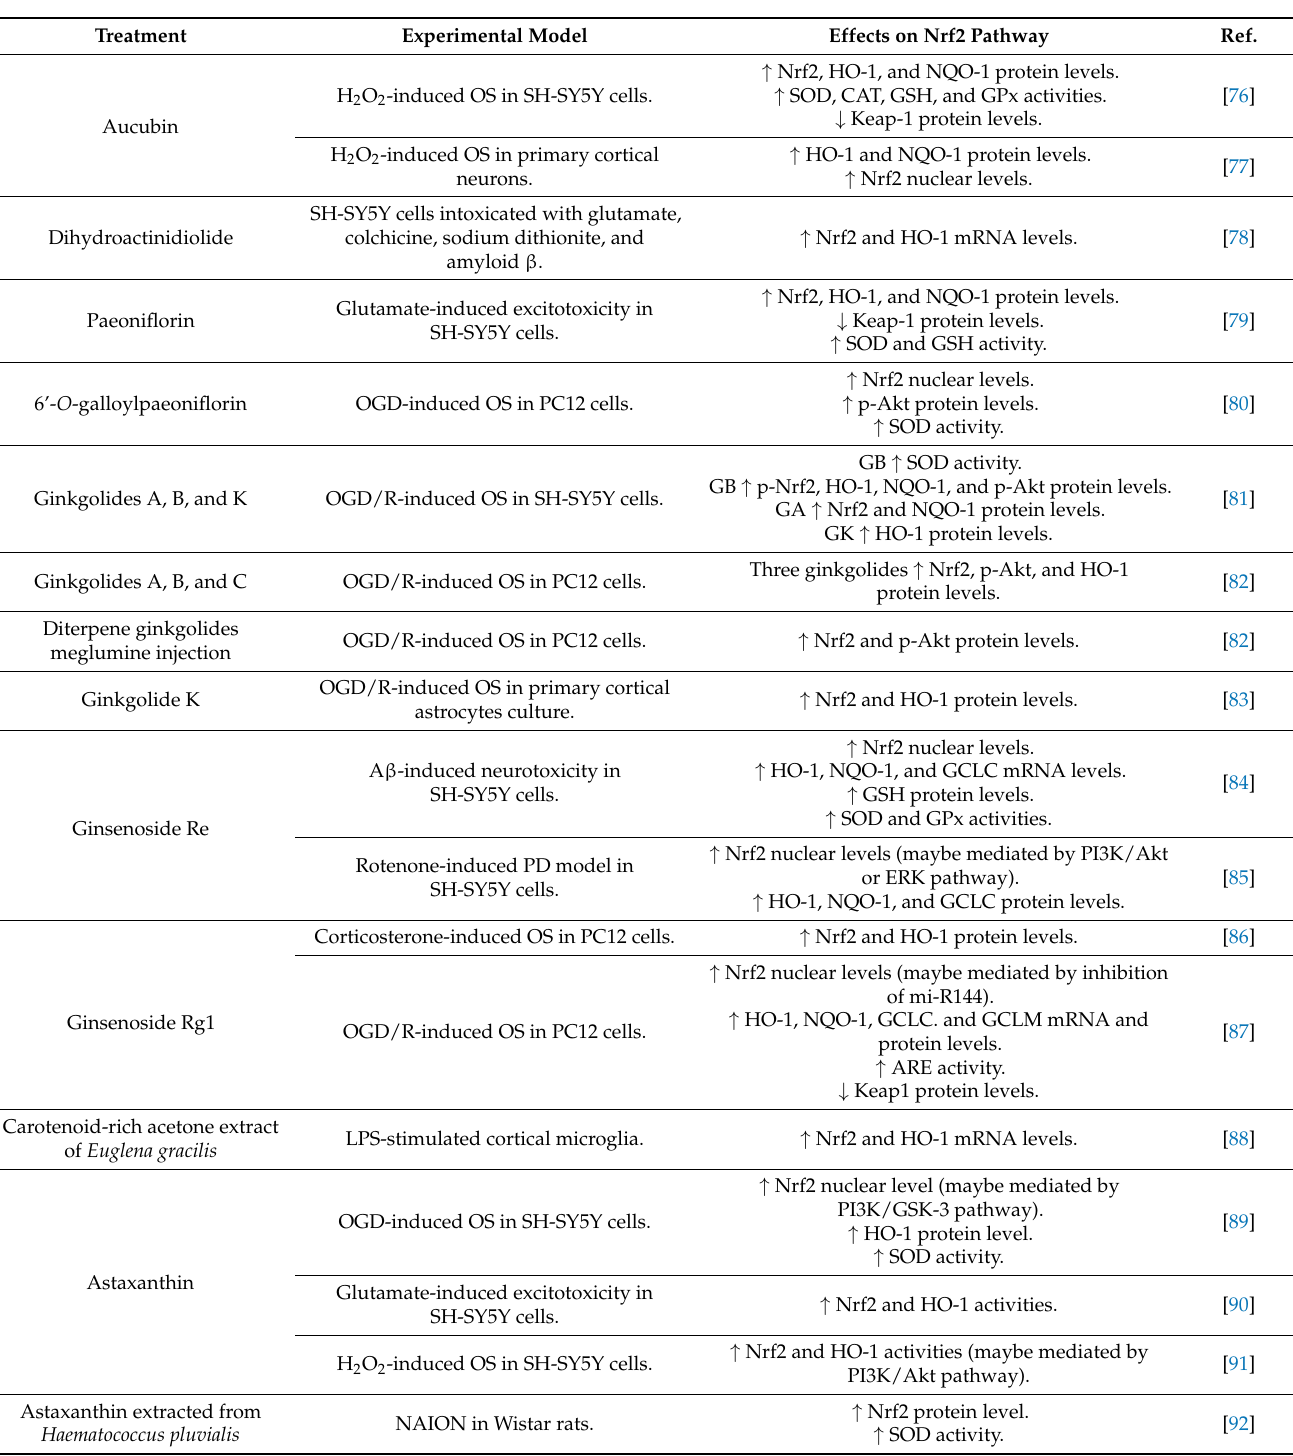
Table 3. Modulation of terpenoids on Nrf2 pathway in in vitro models. The increase in protein or RNAm levels are represented with ( ↑ ) and decrease is represented with ( ↓